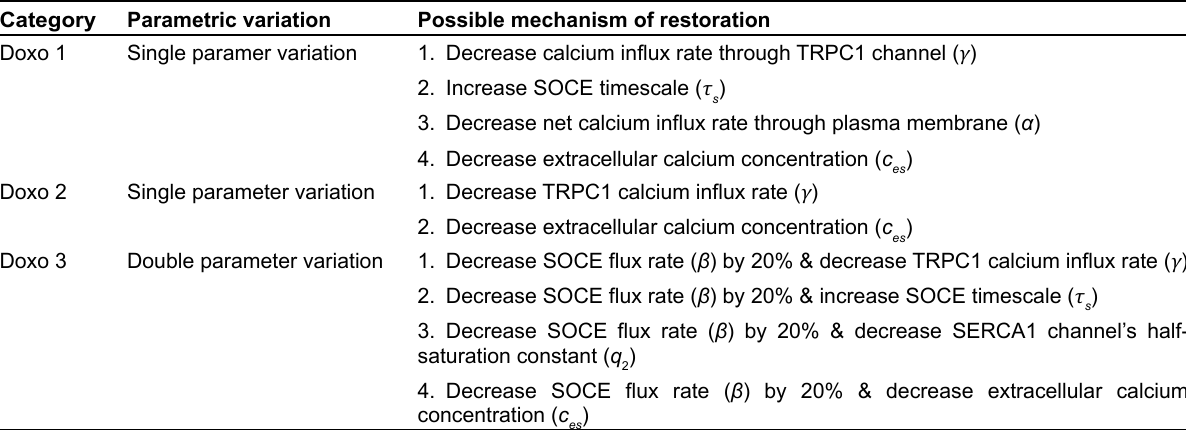
Table 5. Parametric recalibration table: the table describes the possible mechanisms to restore CRD under different parametric conditions. Here Doxo 1, Doxo 2, Doxo 3 denotes the categories when the baseline parameter set is increased by 25%,